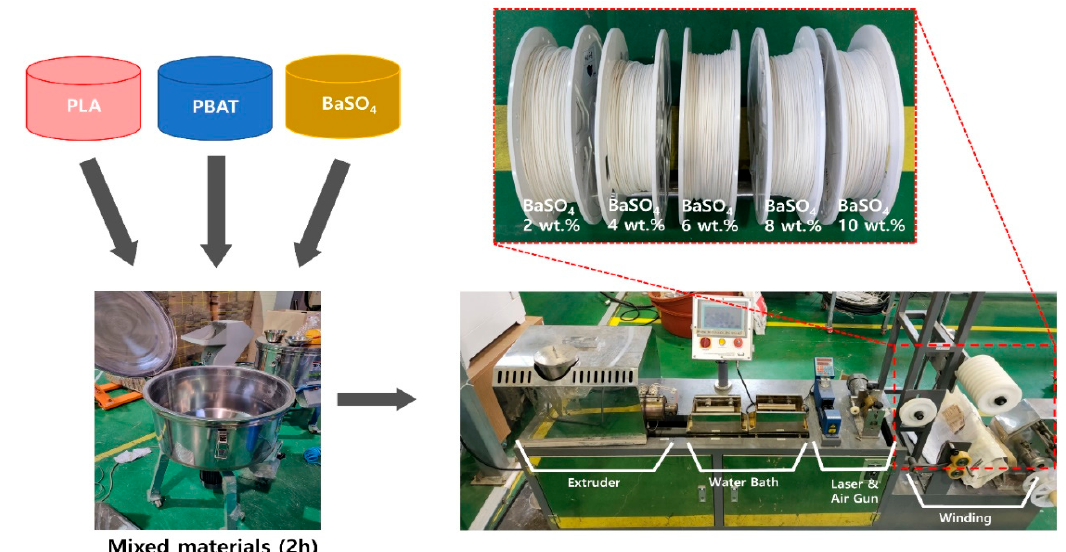
Figure 1. Filament manufacturing process and schematic diagram of the manufactured PLA/PBAT+BaSo 4 mix filament.